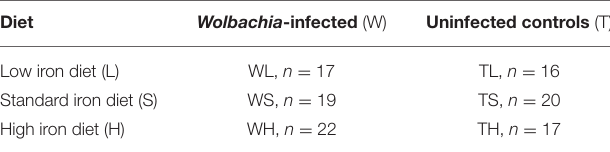
TABLE 1 | Experimental groups and sample